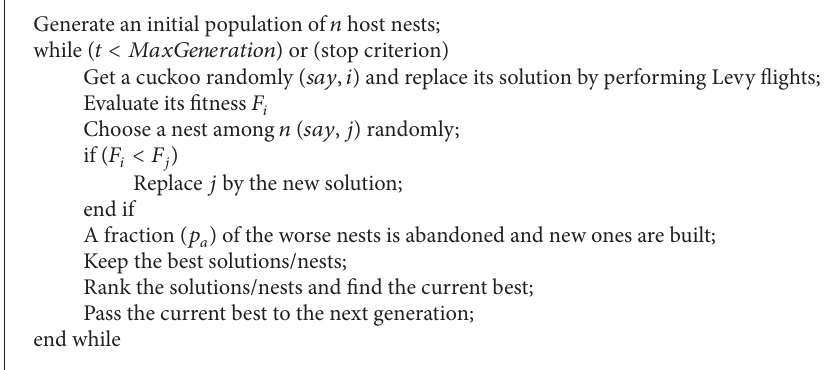
Algorithm 1: Pseudocode for Cuckoo